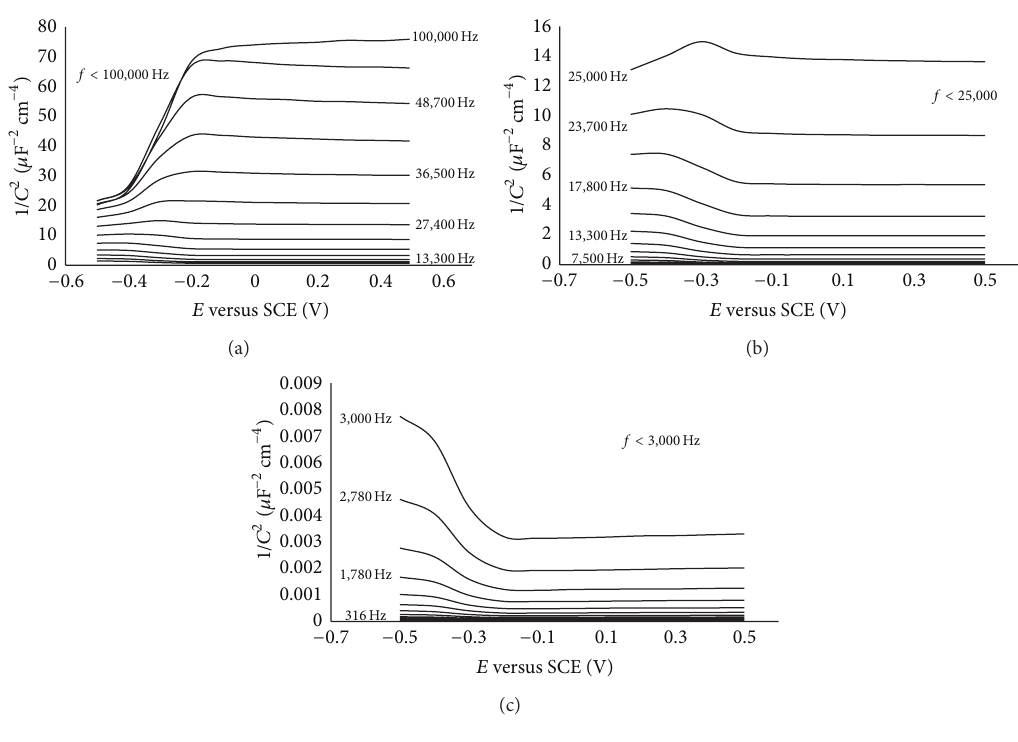
Figure 6: Mott Schottky plots of NTD sample in different ranges of frequencies.